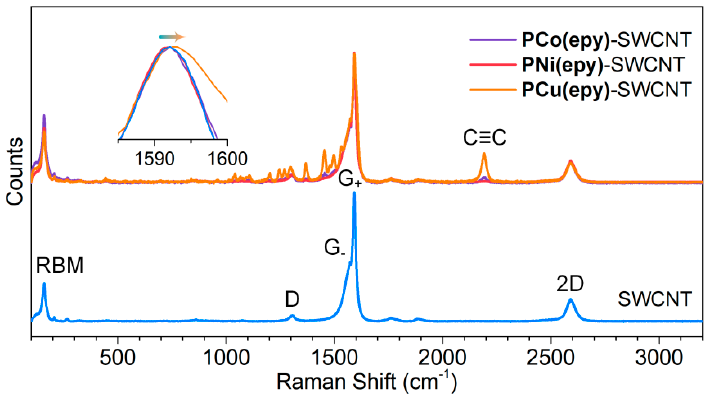
Figure 5. Raman spectra of pure SWCNTs and the PM(epy) -SWCNT composites at f C =